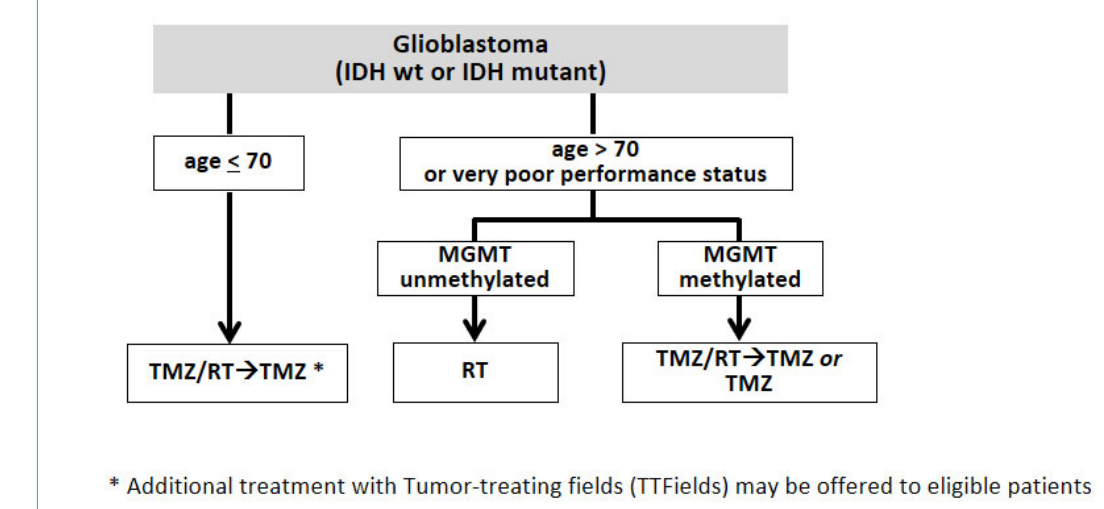
Figure 4: First-line therapy in patients with newly diagnosed glioblastoma . Patients older than 70 years with MGMT-methylated glioblas- toma may receive combined temozolomide-based radiochemotherapy or monotherapy with temozolomide, depending on the performance sta- tus as considered appropriate by the treating physician.IDH = isocitrate dehydrogenase; RT = radiotherapy; TMZ = temozolomide; MGMT = O 6 -methylguanine-DNA